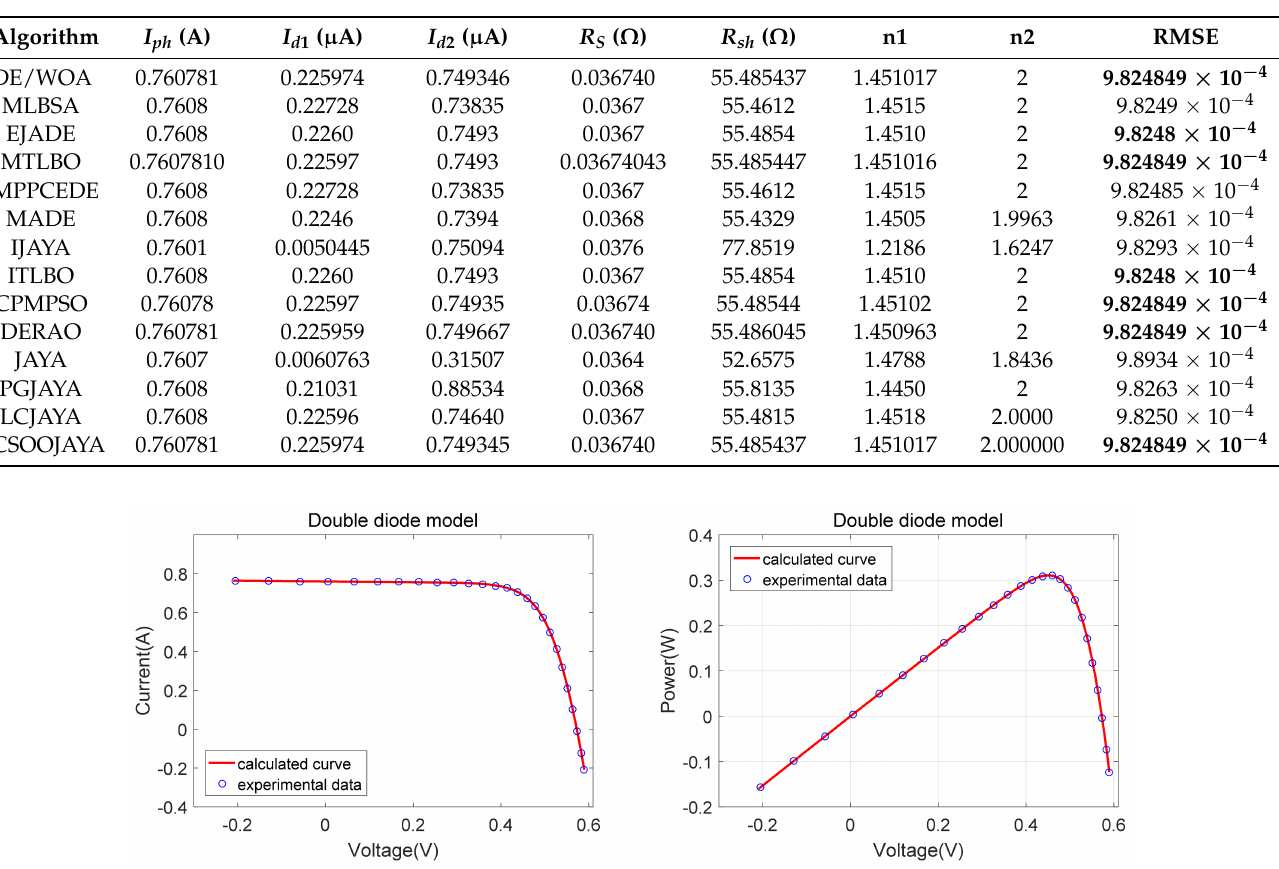
Table 7. Comparison of the extracted optimal parameters of the DDM.